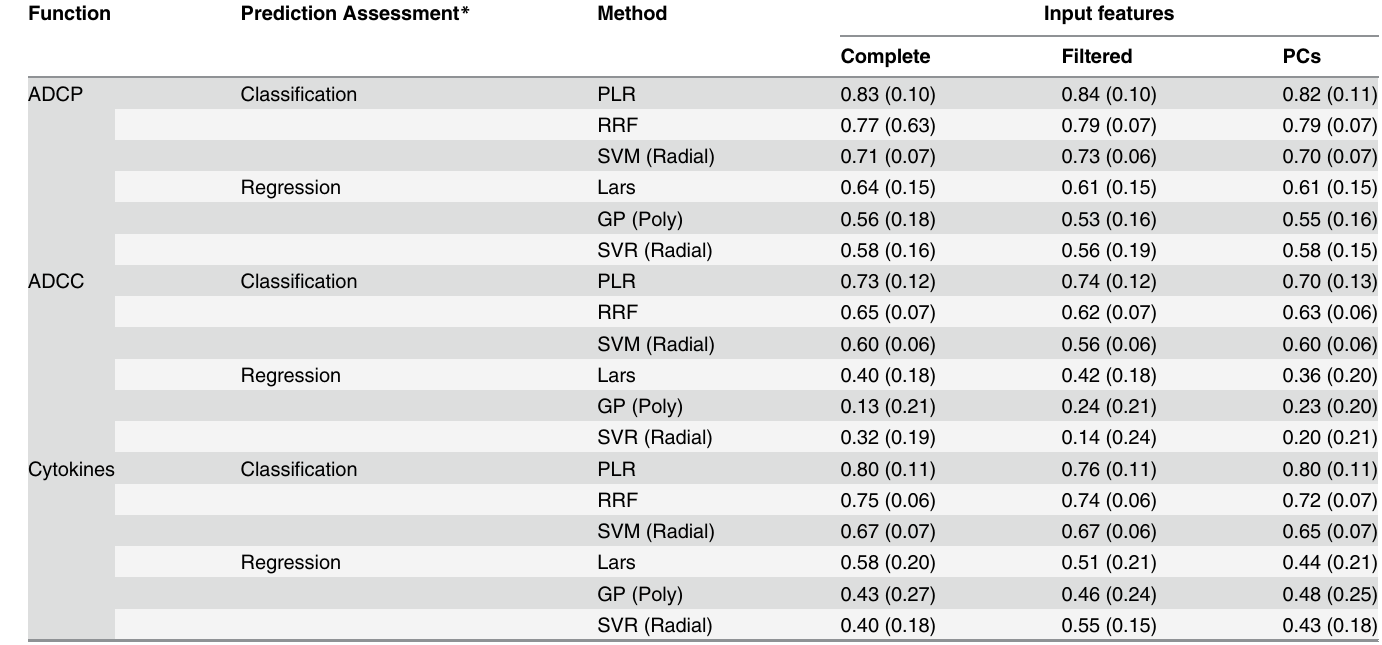
Table 1. Summary of classification (shaded) and regression (unshaded) performance for prediction of antibody function across different input fea- tures and multiple learning techniques. Function Prediction Assessment